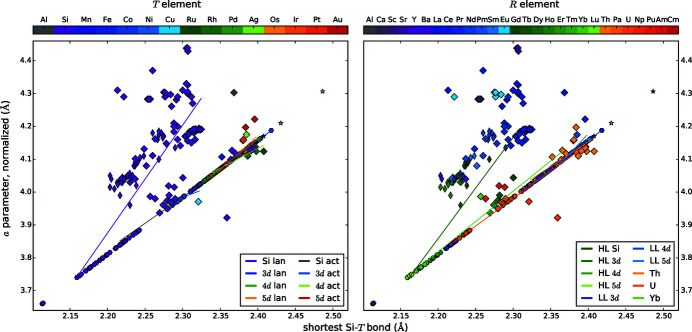
Correlations between the shortest Si—T distance d and the lattice parameter a. For AlB2-like compounds a ∝ d by definition, for ThSi2-like compounds the interrelationship is not linear due to distortions of the trigonal-planar coordination of Si/T atoms.